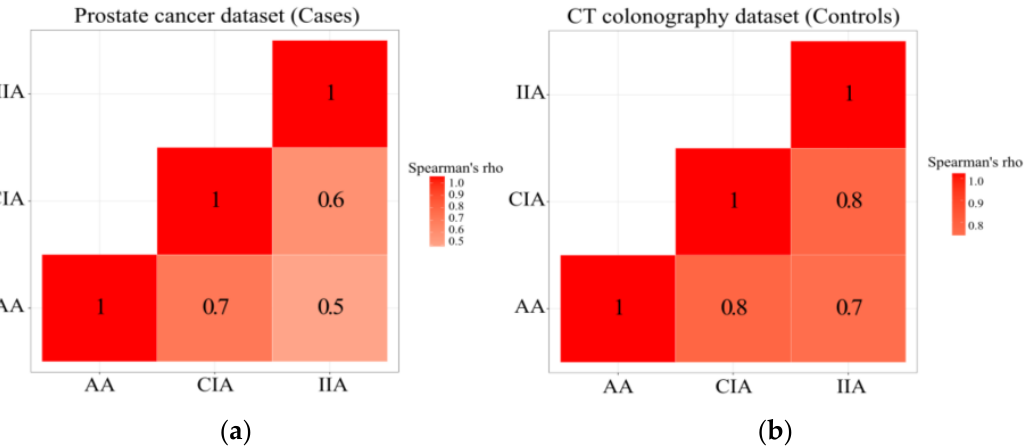
Figure 4. Correlation of Agatston scores between different vessels. ( a ) Correlation of Agatston scores between the abdominal aorta (AA), common iliac arteries (CIA), and internal iliac arteries (IIA) in Cases dataset. ( b ) Correlation of Agatston scores between the AA, CIA, and IIA in the Controls dataset. The scores were first stratified into quartiles before Spearman’s correlation.